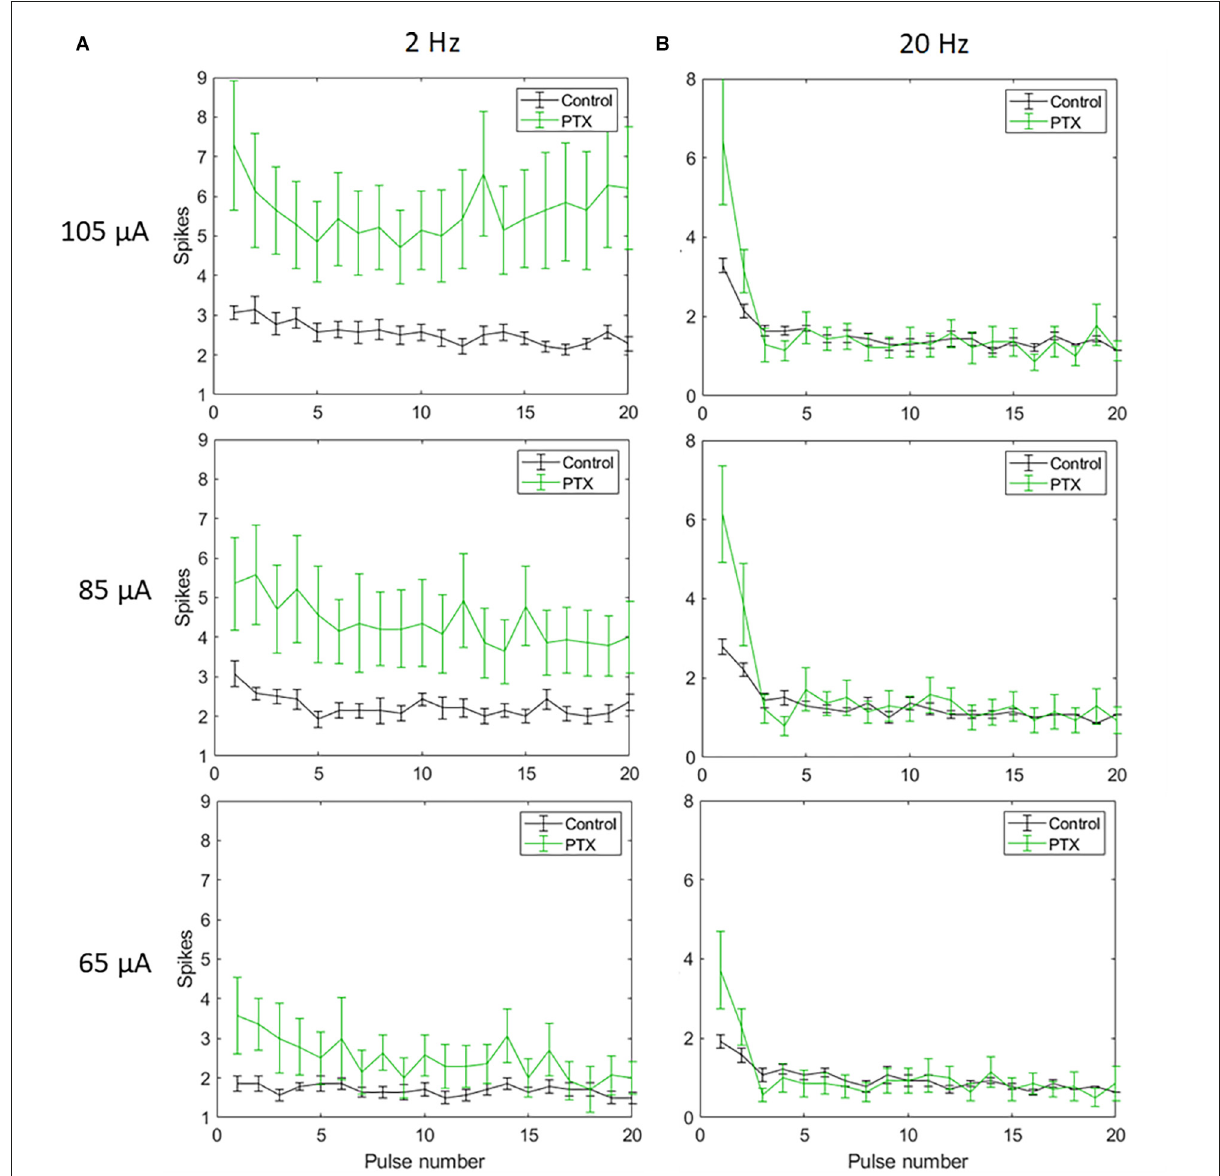
FIGURE5 The effect of PTX on RGC spiking ( n = 14) at different current amplitudes for stimulation delivered at 2 Hz (A) and 20 Hz (B) . The average numbers of RGC spikes in response to 20 pulses delivered at three current amplitudes (65 µ A, 85 µ A, and 105 µ A) are shown in each figure. Evoked spikes are counted in 50 ms bins after the onset of each pulse. Error bars show the standard error of the mean (SEM).